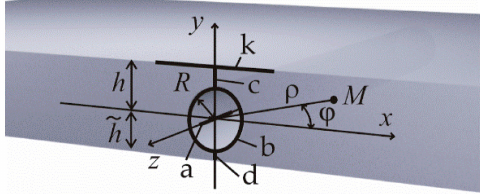
Figure 2. The areas where a stresses was